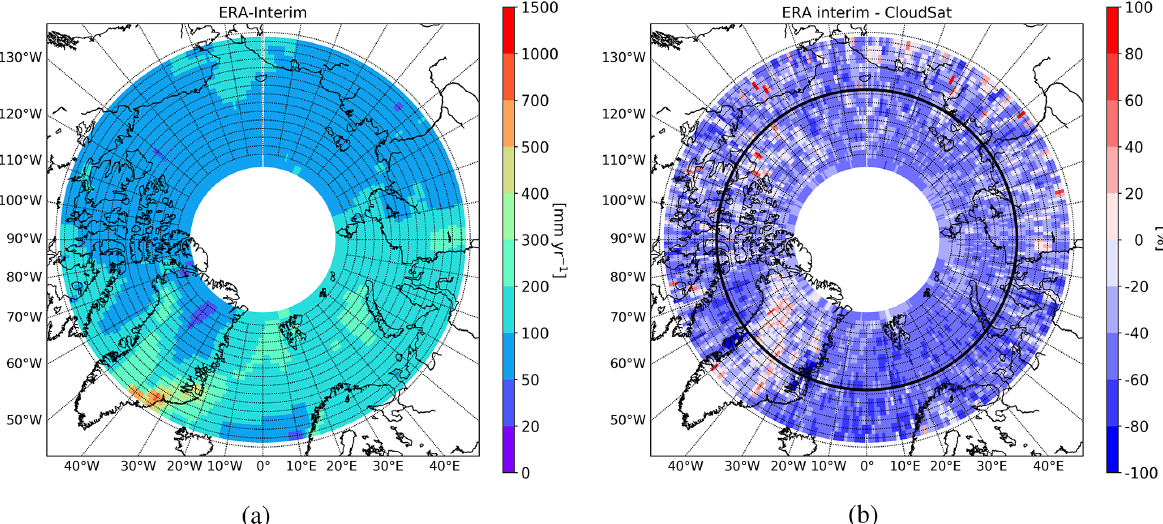
Figure A2. (a) Yearly mean snowfall rate of ERA-Interim. (b) Difference of snowfall rates between ERA-Interim and CloudSat. In (b) the difference plot, the red colors show that ERA-Interim has higher rates, whereas blue colors indicate that CloudSat provides higher rates. Percentages are calculated related to CloudSat observations.